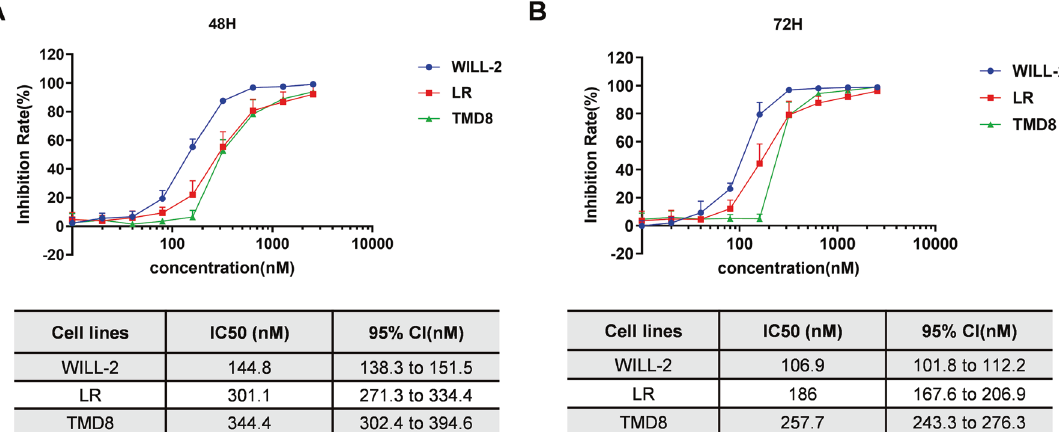
Fig. 2 HZX-02-059 exerts anti-proliferative action of DHL cells in a dose- and time-dependent manner. Inhibition rate and IC 50 values were shown after exposure to indicated concentration of HZX-02-059 for 48 h ( A ) and 72 h ( B ) in DHL cells by CCK-8 assay. Values indicate mean ± S. D. for at least three independent experiments performed in